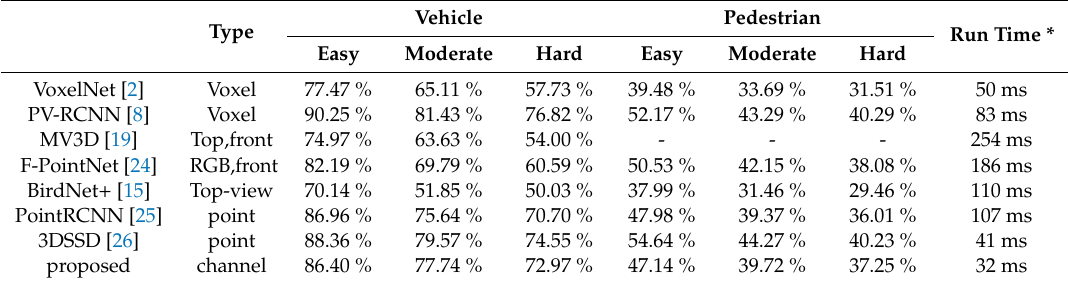
Table 2. Results of KITTI benchmark (3D Object Detection).